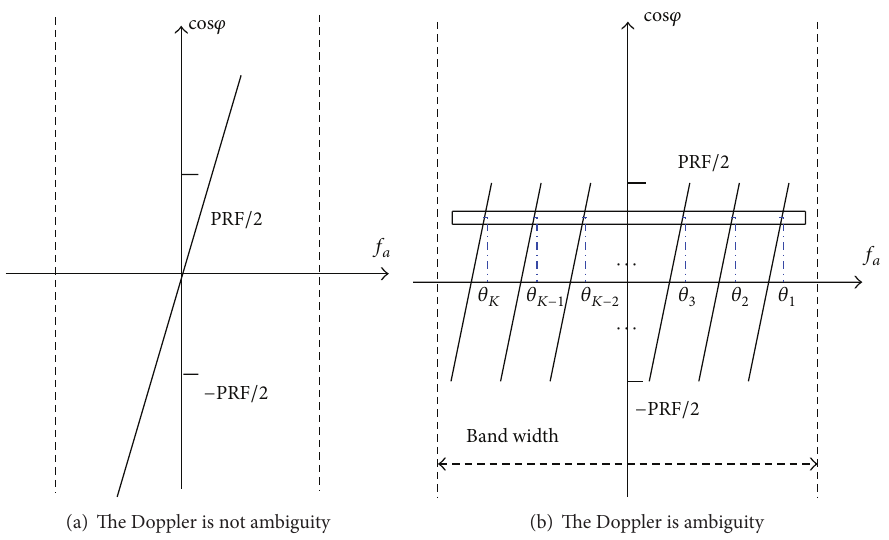
Figure 2: The relationship between cosine of cone angle and